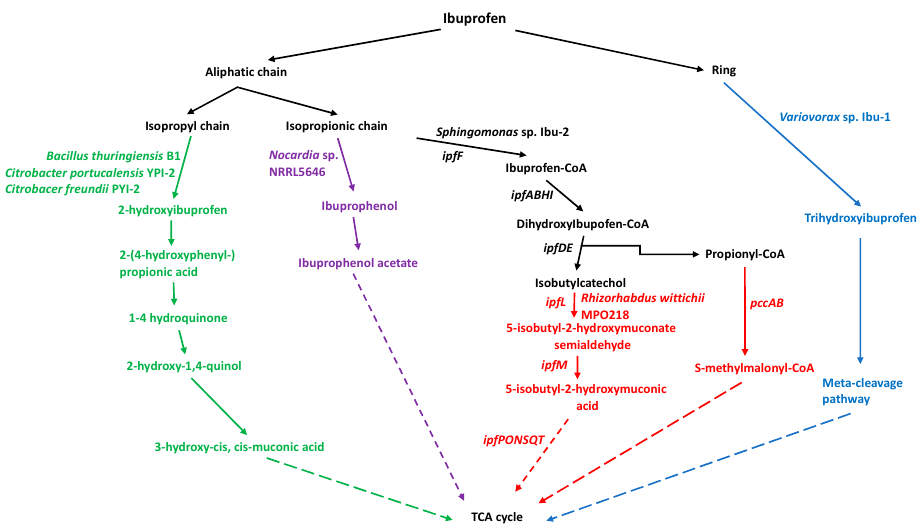
Figure 2. Biodegradation of ibuprofen by bacteria. The colors represent the metabolic pathways used by each bacterial genus. Dotted lines mean that there are more steps during the biodegradation process.